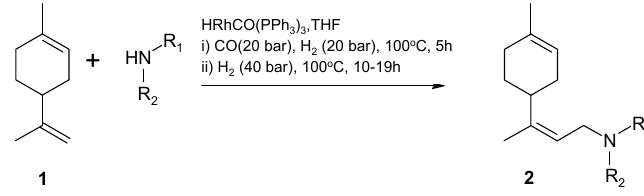
Figure 8. Hydroaminomethylation of limonene ( 1 ) with secondary amines, Y—yield of product: 2a —